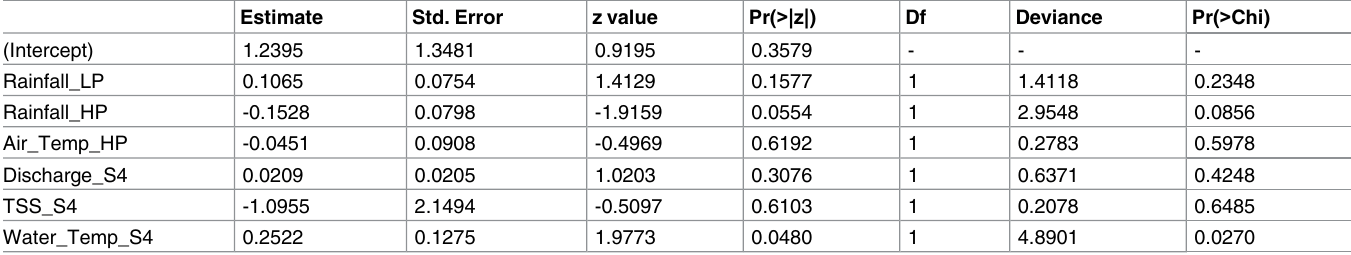
Table 4. Effect of environmental variables on E . coli counts in S4 from May 2011 to December2012. The last 3 columnspresent the results of the LRT and show the significances of each variable,correcting for the potentialconfounding effects of the other variables. No auto-regressive coefficient was included in the model since no significanttemporalauto-correlation was detected by the Durbin-Watson test.